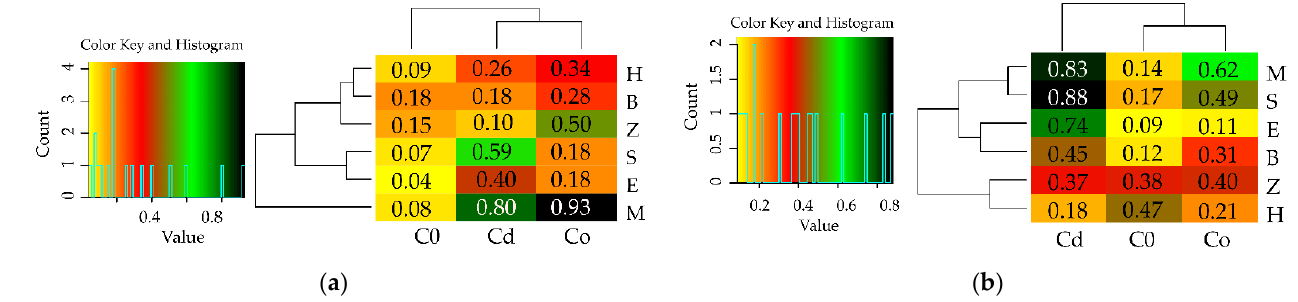
Figure 8. Index of the influence of adsorbents (IF Ad ) on the yield of the part ( a ) aboveground plants, ( b ) roots of plants.